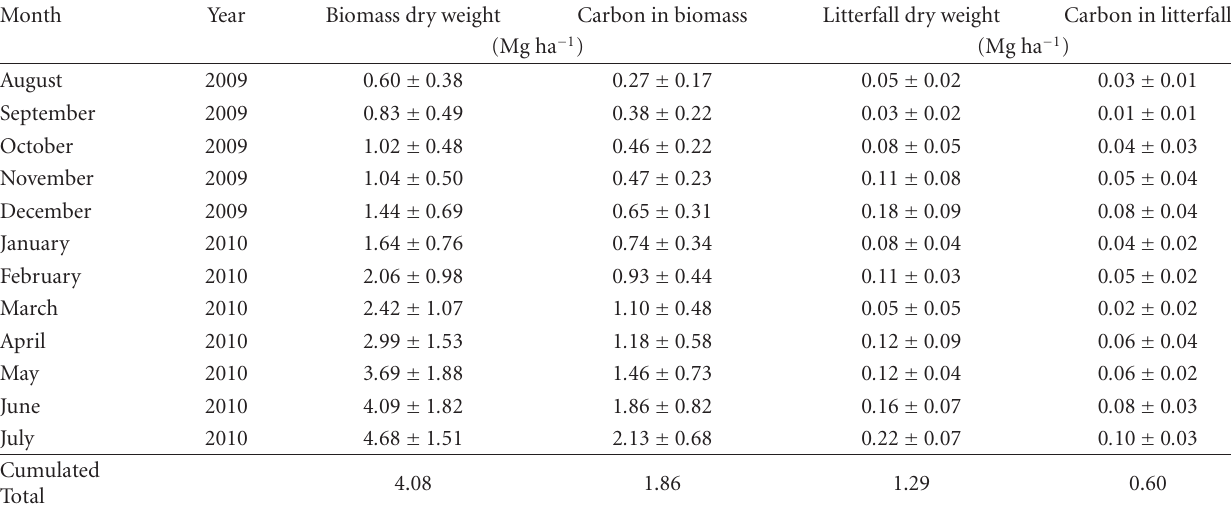
Table 3: Estimated monthly dry weight of biomass and litterfall of Jatropha curcas and mass of carbon stored in each respective part (mean ± standard error).